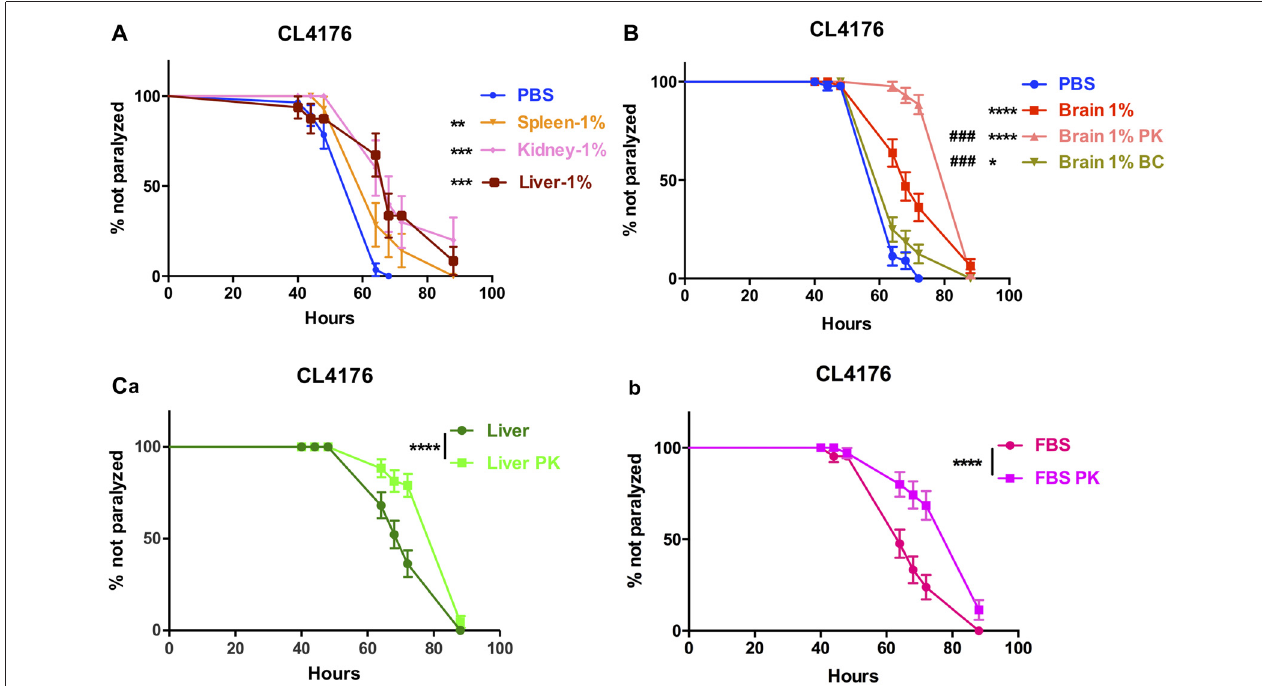
FIGURE 3 | The effects of brain extracts, peripheral tissue extracts and FBS with extra treatment in CL4176. (A) The effects of extracts from spleen, kidney and liver on paralysis at 1% concentration. (B) The compromised effect of brain extracts after boiling plus centrifugation and the enhanced protective effects of brain extracts after PK plus boiling treatment. (C) The enhanced protective effects of liver extracts (a) and FBS (b) after PK treatment. Data were analyzed using a paired log rank survival test. ∗ P < 0.05, ∗∗ P < 0.01, ∗∗∗ P < 0.001, ∗∗∗∗ P < 0.0001, ### P < 0.001.